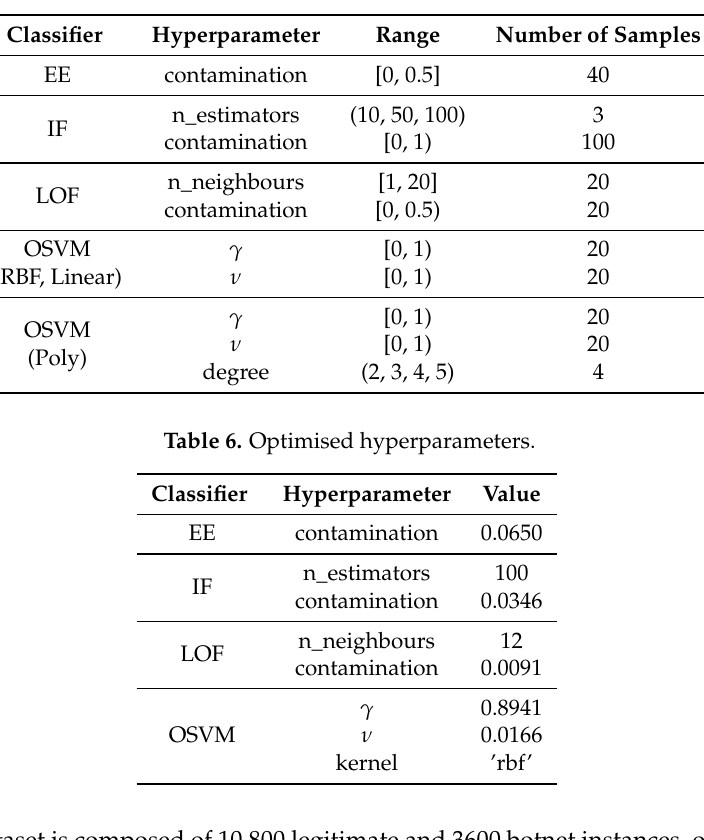
Table 5. Hyperparameters’ ranges evaluated to find the best performance.